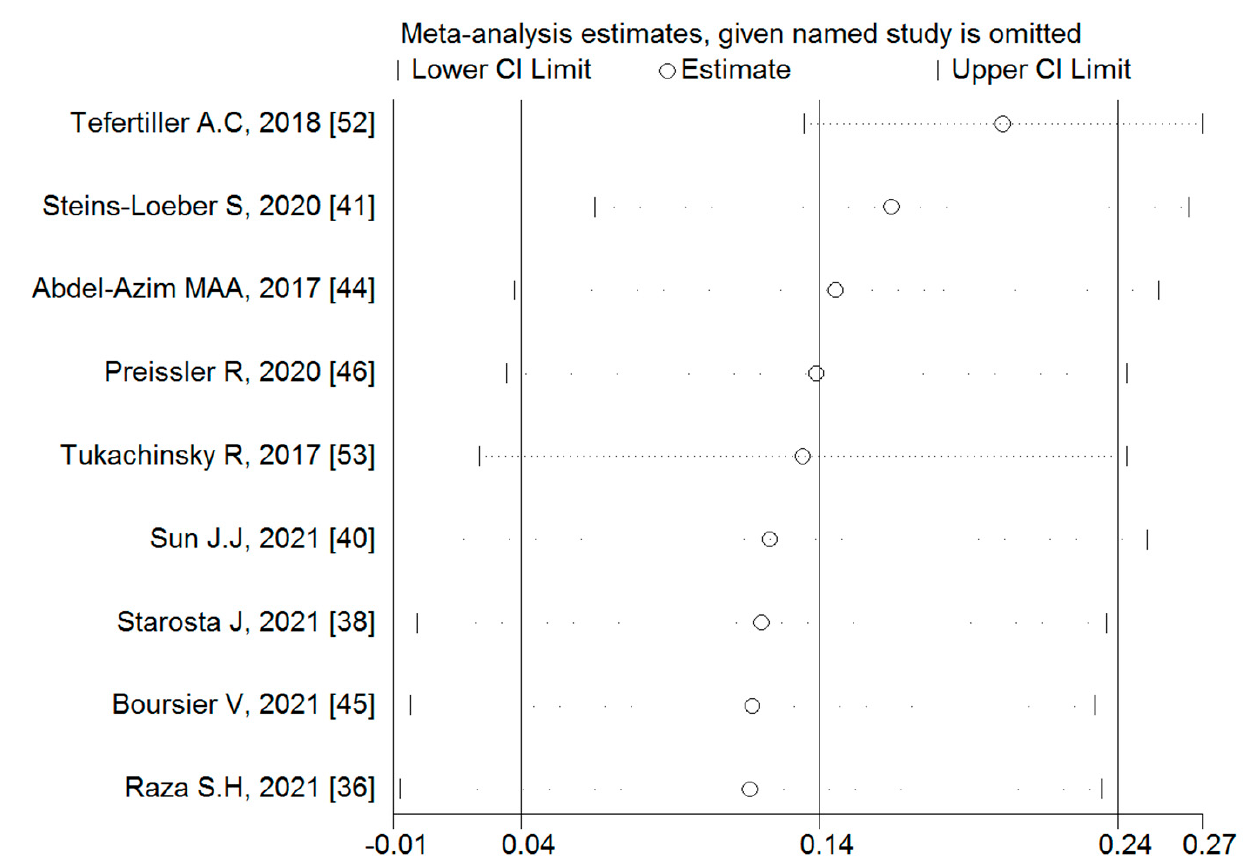
Figure 5. The sensitivity analysis plot assessing the small study effect in the estimated pooled Fisher’s z-score in the association between binge-watching and depression.